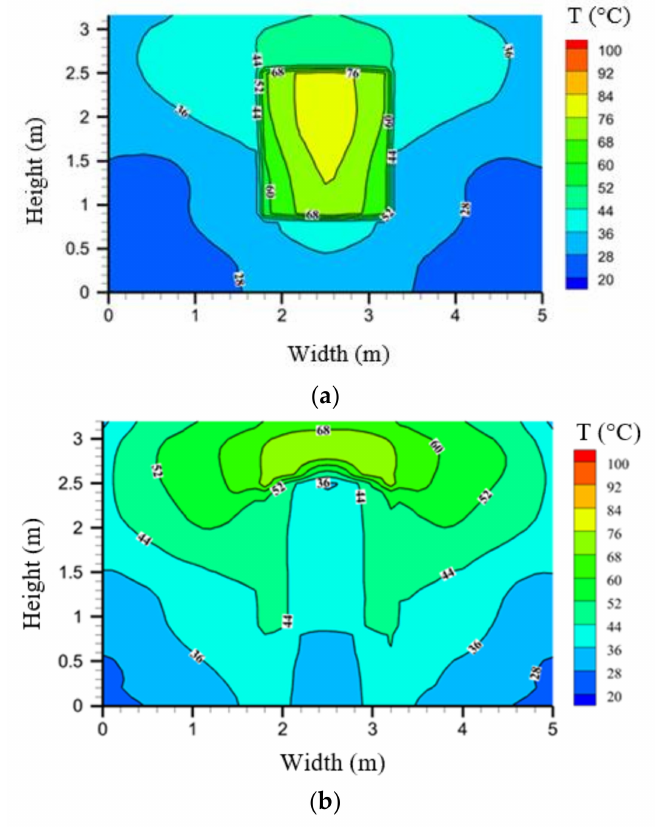
Figure 12. Temperature field of the glass surface under window sprinkler conditions: ( a ) 50 s, ( b ) 150 s.